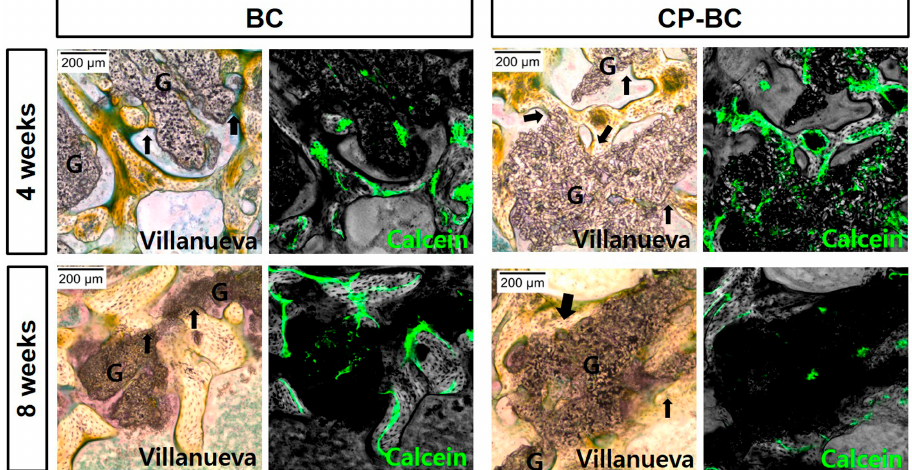
Figure 7. Representative images of bone tissue regeneration inside defects with untreated (BC) and treated (CP-BC) biphasic grafting materials at four and eight weeks by conventional histological staining (left, 100 × , Villanueva bone staining, light microscopy). The newly-formed bone was in direct contact with the grafting materials in some positions (arrows). Mineralized bone (unstained) and seams of osteoids (yellowish green) are shown. G indicates grafting materials. Calcein (green), which was injected two weeks before sacrifice were also observed by confocal laser scanning microscopy in the same sections (right).